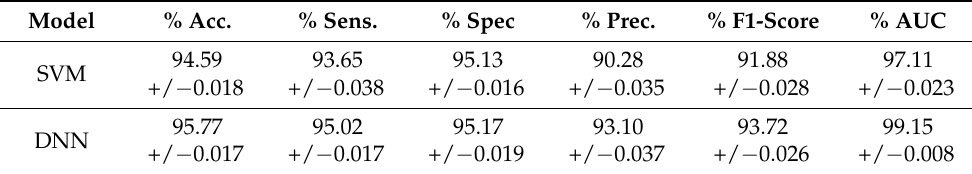
Table 3. Model’s scores on test data.